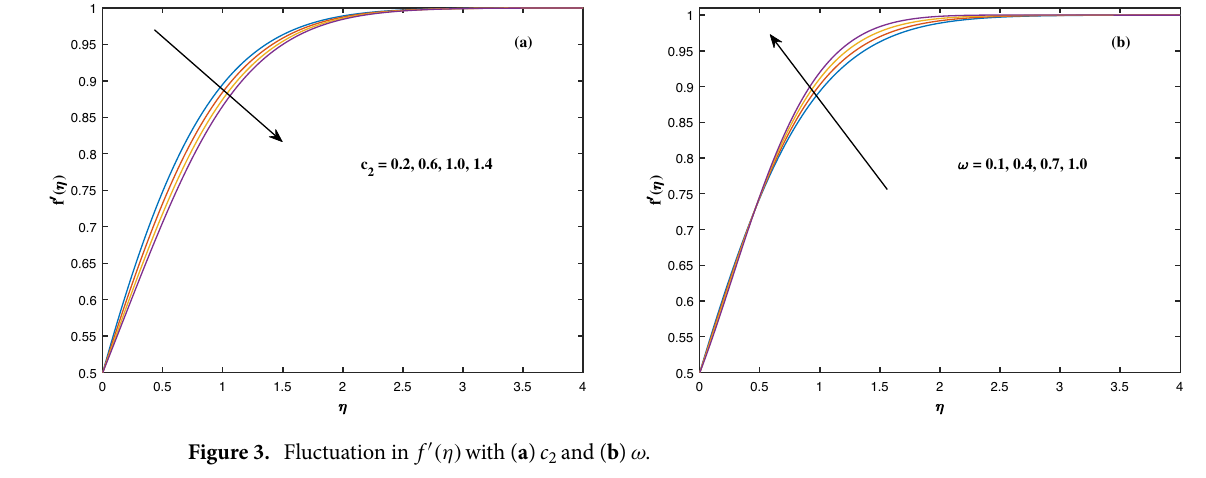
Figure 3. Fluctuation in f ′ (η) with ( a ) c 2 and ( b ) ω .